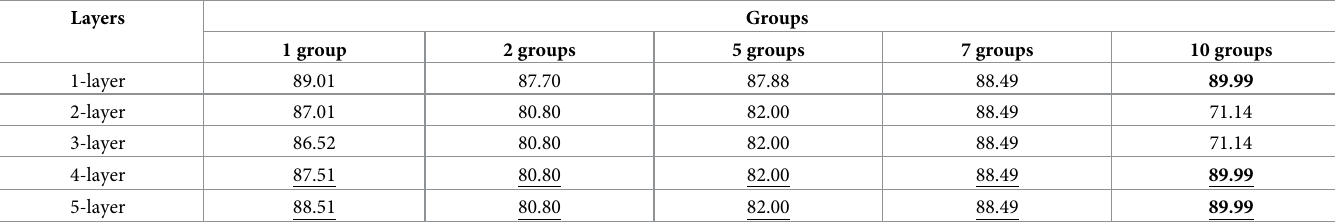
Table 7. Classification performance(%) at each layer where the car-tire class is positive. Layers